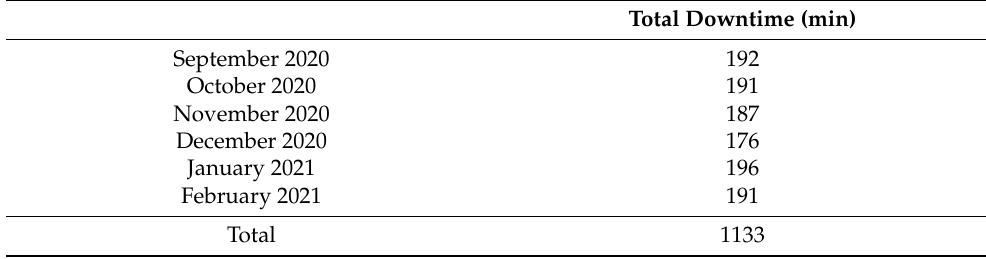
Table 2. Downtimes before using DT.